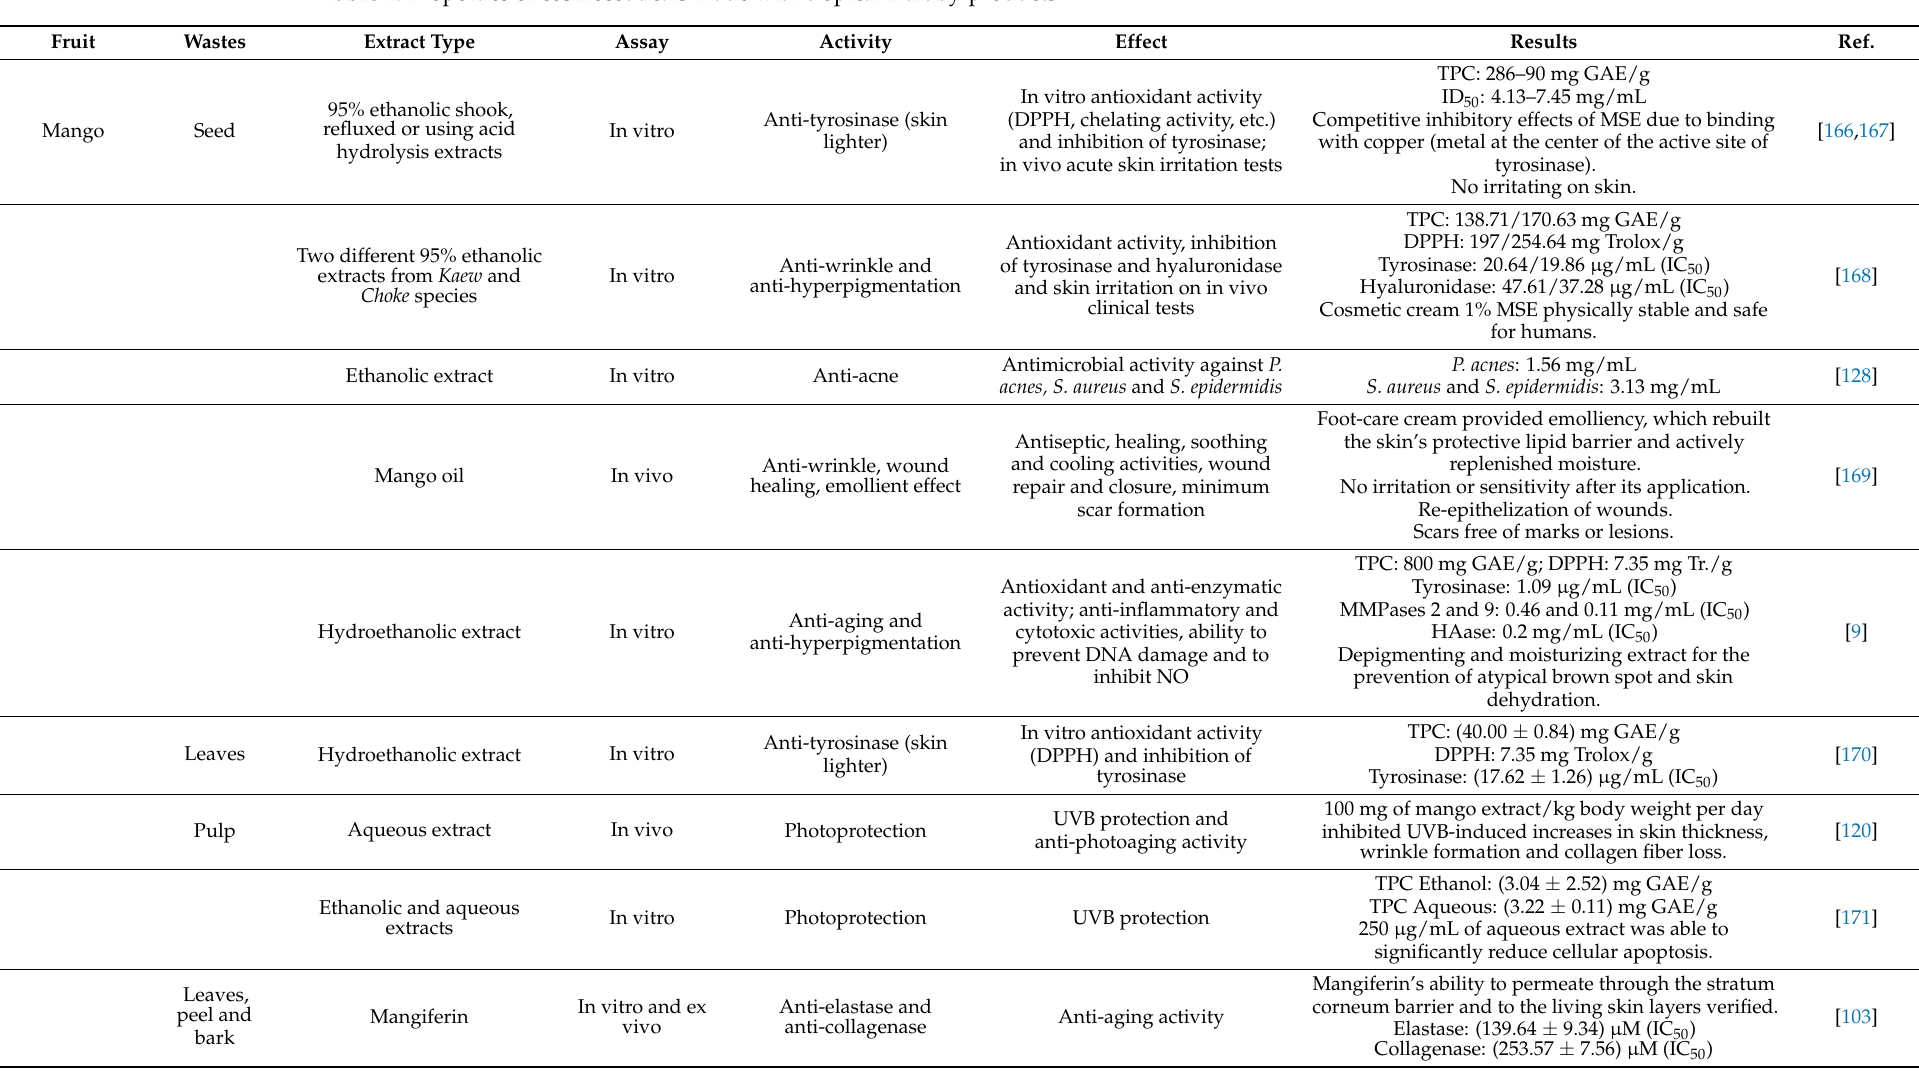
Table 2. Properties of cosmeceuticals made with tropical fruit